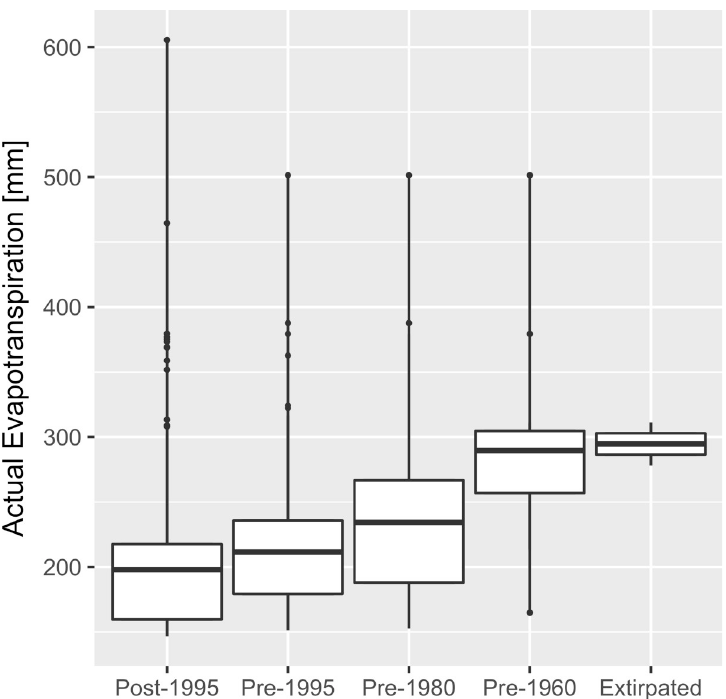
Fig 4. Climatic niche contraction in Gambelia sila . Actual evapotranspiration (AET) at G . sila occurrence locations on undeveloped habitat is higher at sites where G . sila have not been seen for longer and where G . sila are now extirpated (Kruskal-Wallis rank sum test, P < 0.001). Categories are unique locations (5-km radius) where G . sila either persist in the modern era (post-1995), were detected only within the given range of years (pre-1995, pre-1980, pre-1960), or where extensive surveys have confirmed extirpation (see Fig 1). Boxes and whiskers depict the median, interquartile, and